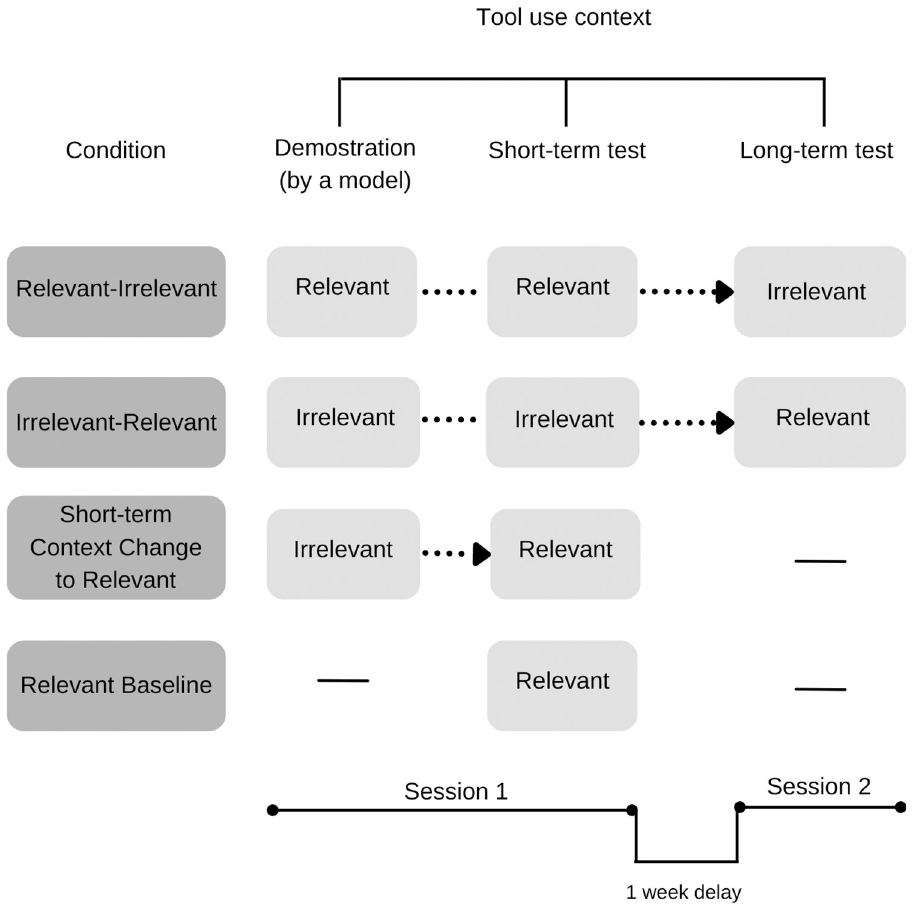
Fig 2. Experimental design of the study. Conditions could consist of three phases: demonstration, short-term re- enactment, and delayed re-enactment. The demonstration and short-term re-enactment took place at the same occasion, in Session 1. One week later, in Session 2 only the delayed re-enactment took place. Tool use context (relevant/irrelevant) changed between or within sessions according to the